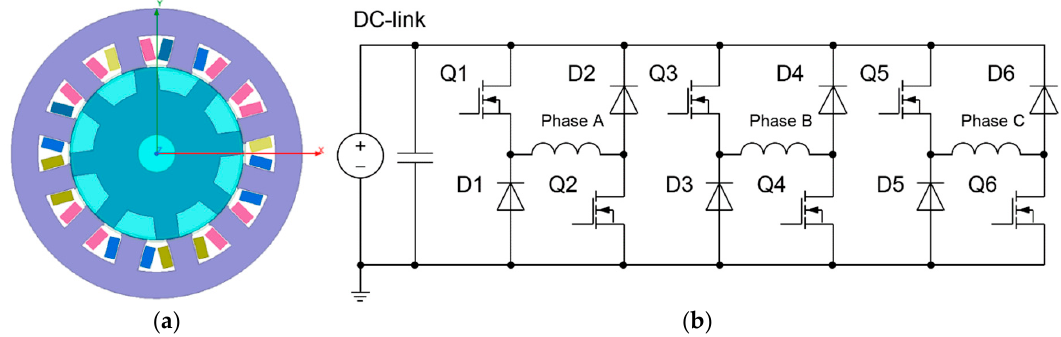
Figure 1. ( a ) Geometry of the switched reluctance motor; ( b ) standard asymmetric H-bridge converter topology.